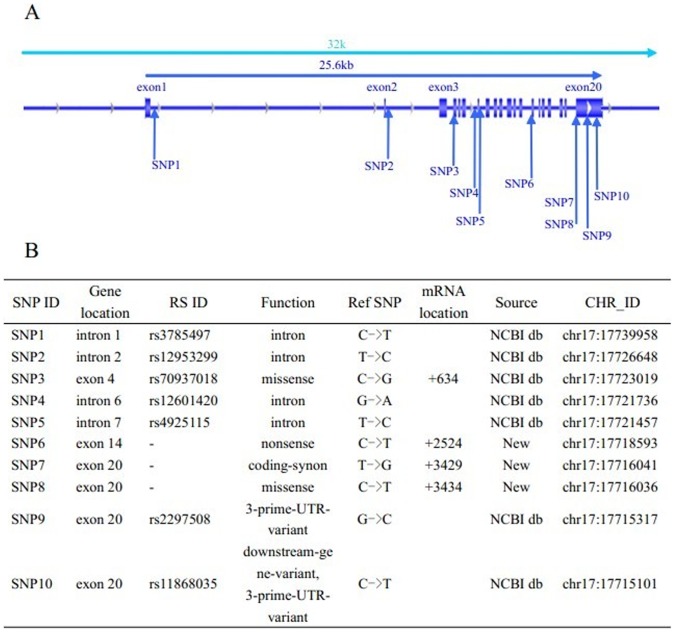
A: SNPs in SREBF-1 gene. The whole SREBF-1gene includes 22 exons. Ten SNPs (SNP1 to SNP10) were identified within the SREBF-1 in our study. FIG. 1 B: SNP ID. SNP1 to SNP10 are listed from 5′-3′ of the SREBF-1. “CHR-ID” shows chromosome ID of ten SNPs in SREBF-1. Listed “RS ID” has been reported in ucsc or NCBI website, “-” expresses newly detected SNP. “Function” column listed altered genetically coded function of the SNPs. “Ref SNP” shows SNP form in original reference sequence. In “mRNA location”, corresponding mRNA positions are showed in consistent with each SNP. (For details:Sequence IDs included in CCDS 32583.1). NCBI db is available from http://www.ncbi.nlm.nih.gov/SNP.